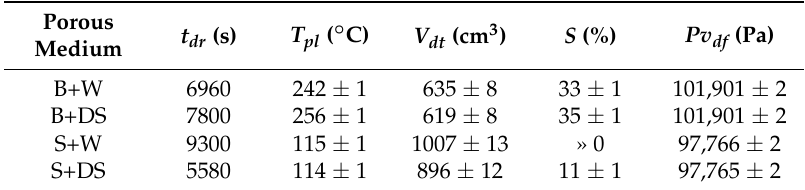
Table 7. Total dryout